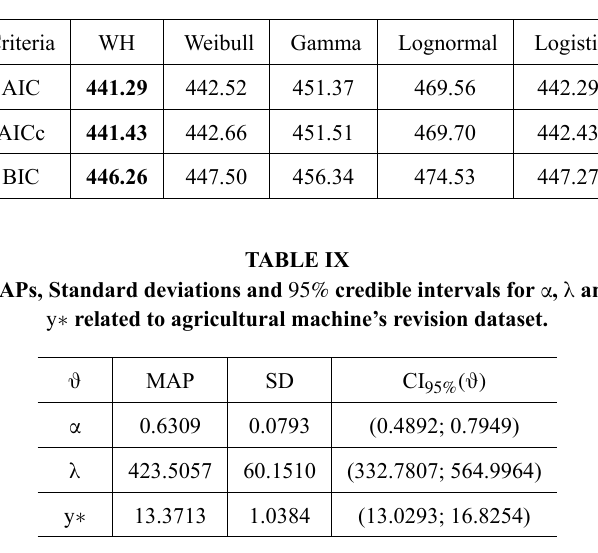
Results of AIC, AICc and BIC criteria for all fitted distributions considering the dataset related to the agricultural machine’s revision.